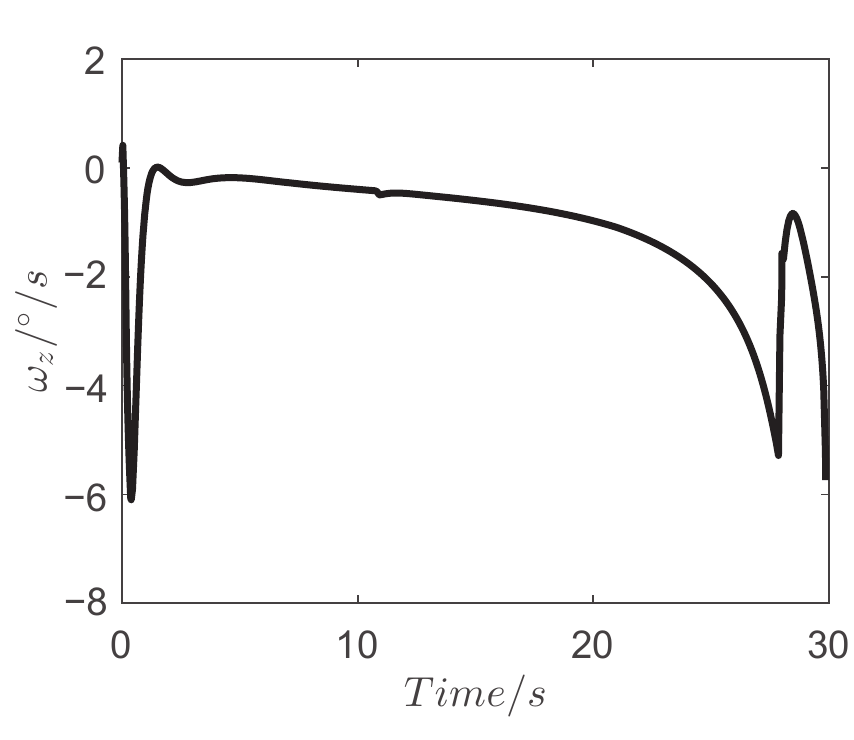
Figure 9. Curve of the pitch rate ω z